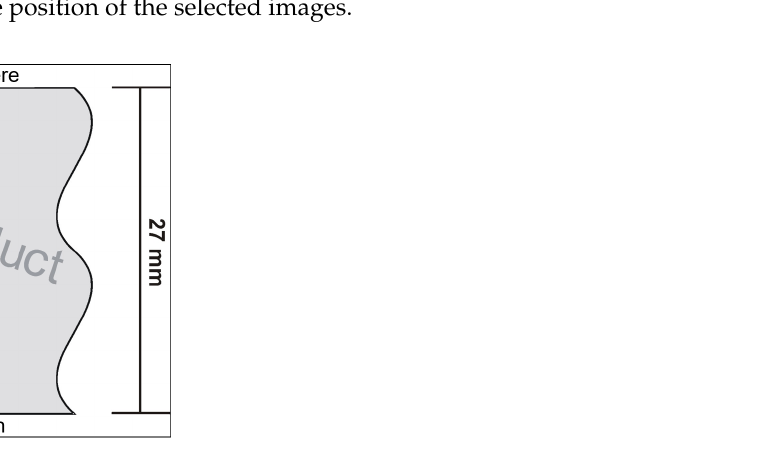
Figure 13. Drawing of the point where the sample was taken from the silicide product to conduct the SEM analysis shown in Figure 14.